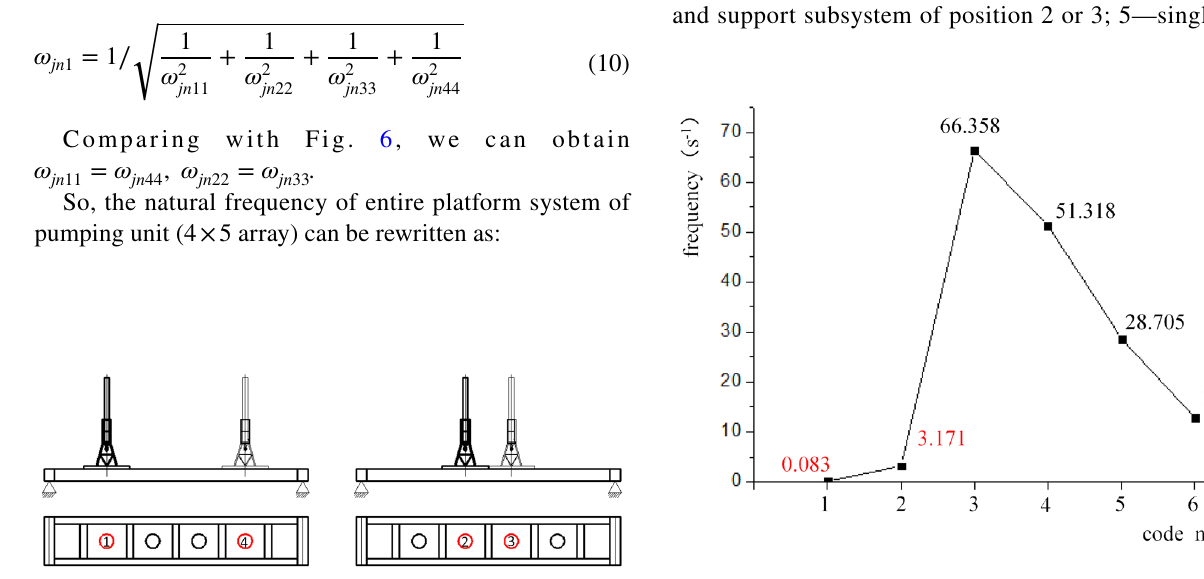
Fig. 6 Schematic diagram of single-well installation